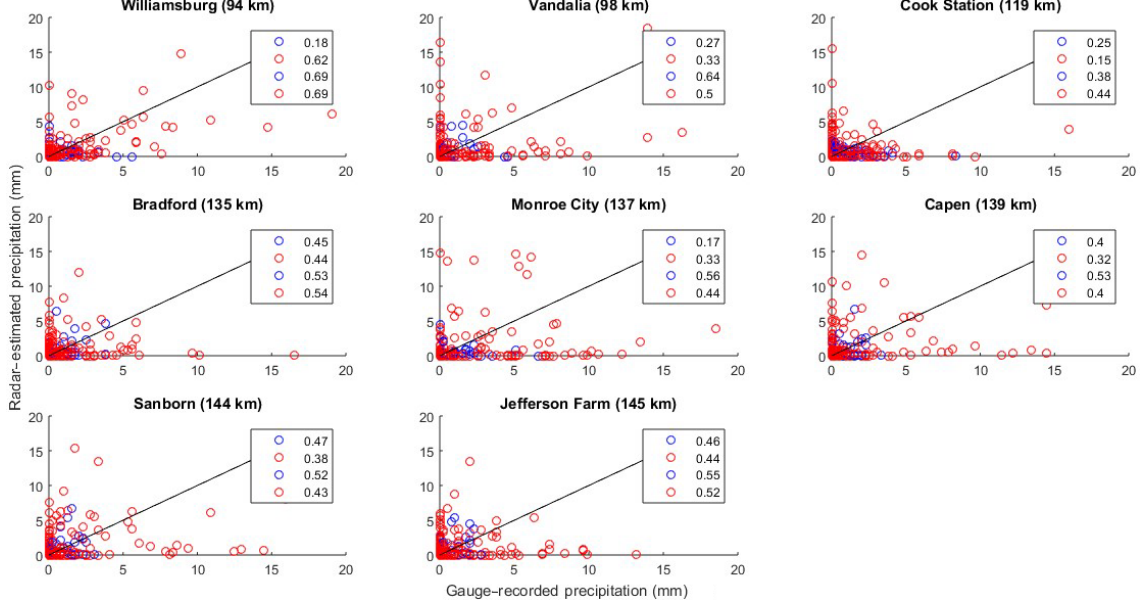
Figure 6. Correlation coefficient values for the eight locations analyzed by the St. Louis radar with the R ( Z ,ZDR) NSSL equation. Blue and red scatter points represent the cool and warm season data, respectively. The top two numbers on each plot indicate the overall R 2 value, whereas the bottom two numbers represent the R 2 when false alarms and misses are